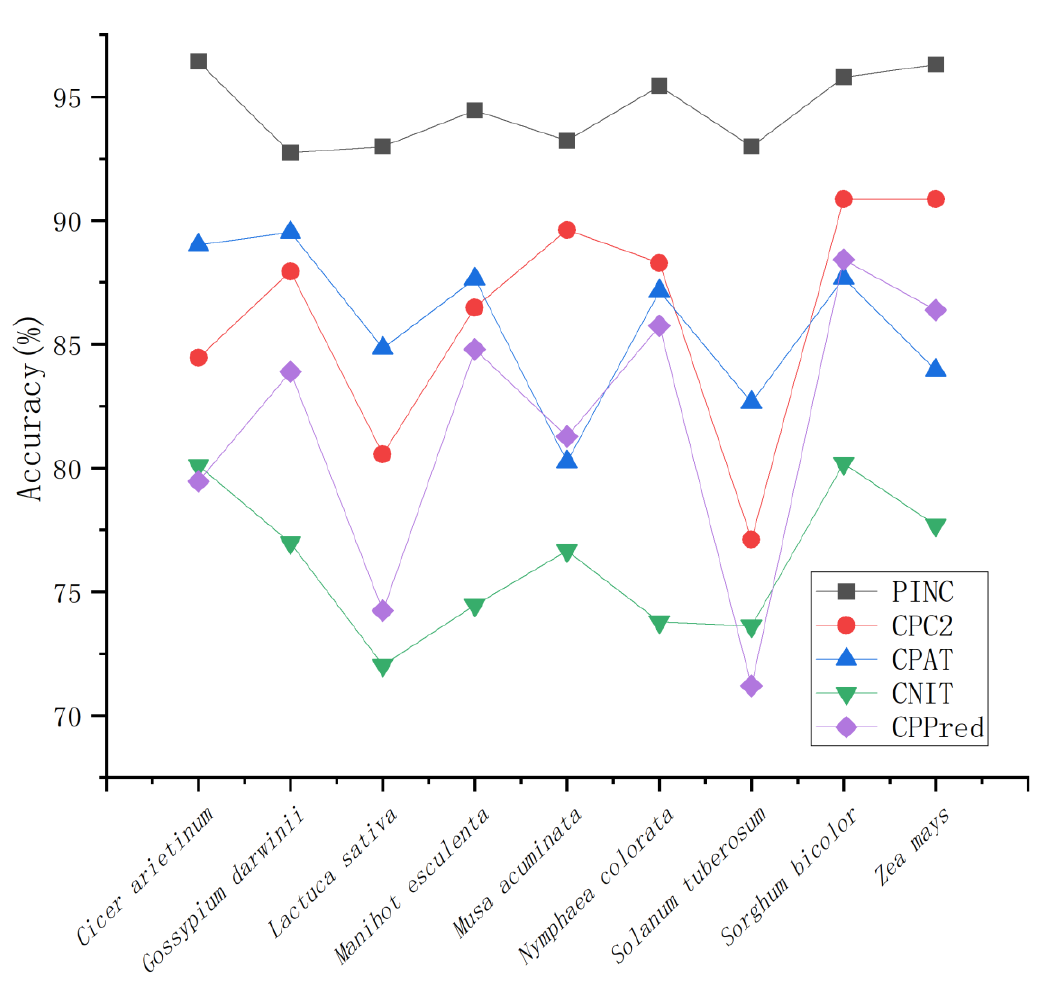
Figure 4 . Comparing the identification accuracy of nine independent test sets across five tools.